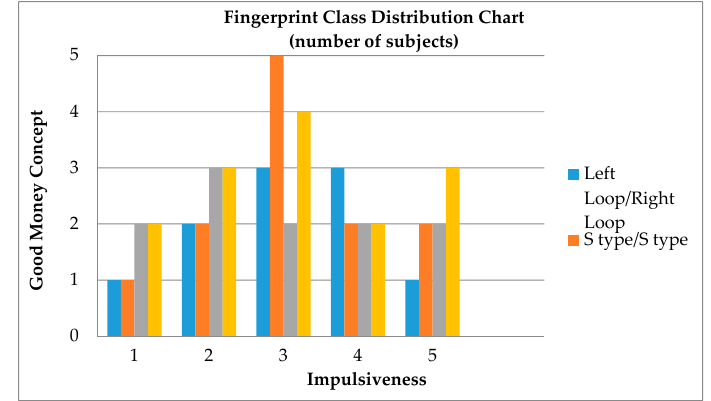
Figure 4. A sample distributed chart of personality traits.